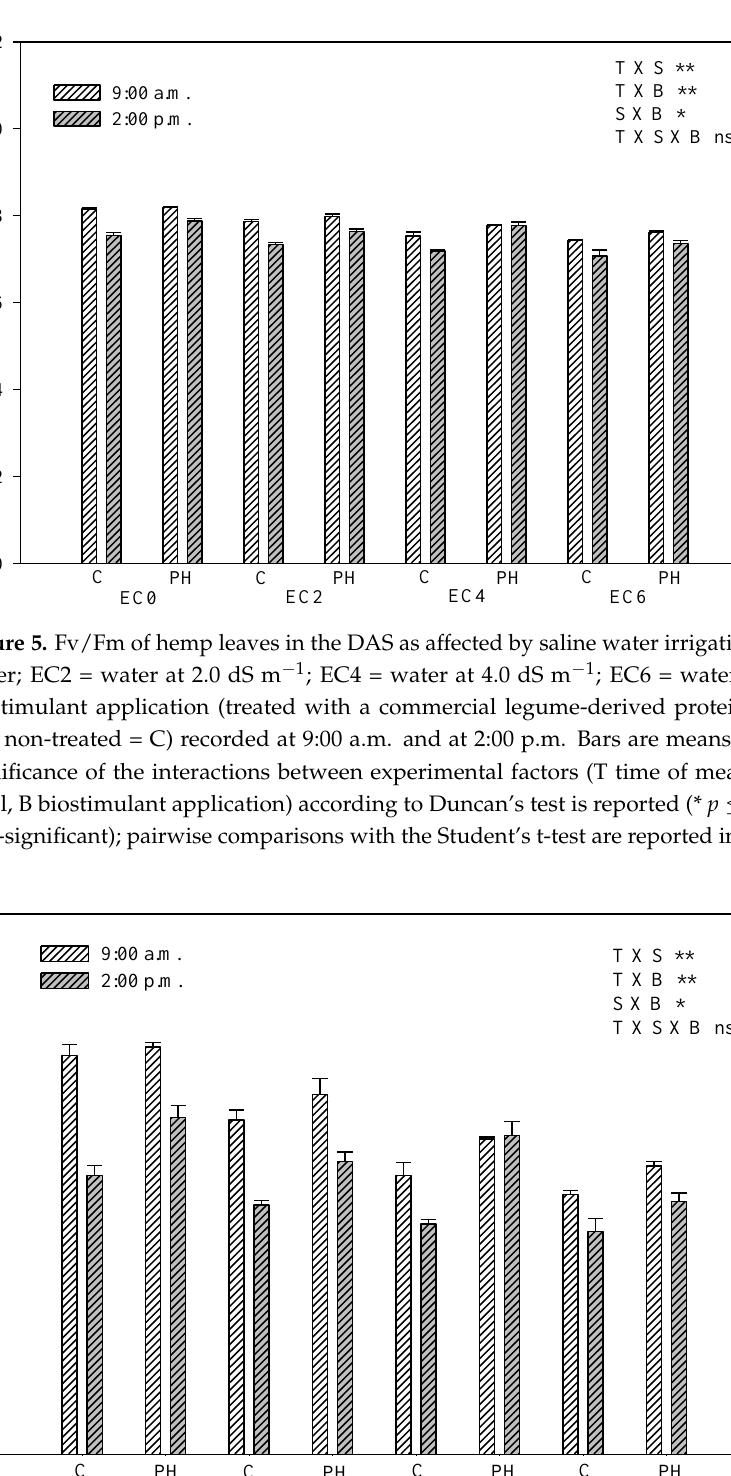
Figure 6. Fv/F0 of hemp leaves in the DAS as affected by saline water irrigation (EC0 = non-saline water; EC2 = water at 2.0 dS m − 1 ; EC4 = water at 4.0 dS m − 1 ; EC6 = water at 6.0 dS m − 1 ) and biostimulant application (treated with a commercial legume-derived protein hydrolysate = PH and non-treated = C) recorded at 9:00 a.m. and at 2:00 p.m. Bars are means ± s.e. ( n = 10). The significance of the interactions between experimental factors (T time of measurement, S salinity level, B biostimulant application) according to Duncan’s test is reported (* p ≤ 0.05, ** p ≤ 0.01, ns non-significant); pairwise comparisons with the Student’s t-test are reported in Table